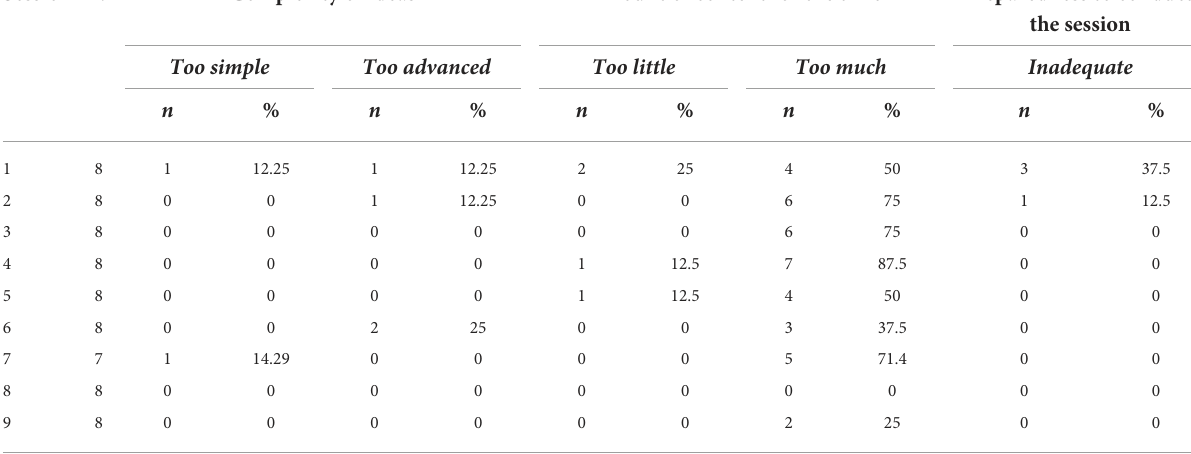
TABLE 3 Facilitators-rated perceived feasibility of delivery of group session. Session